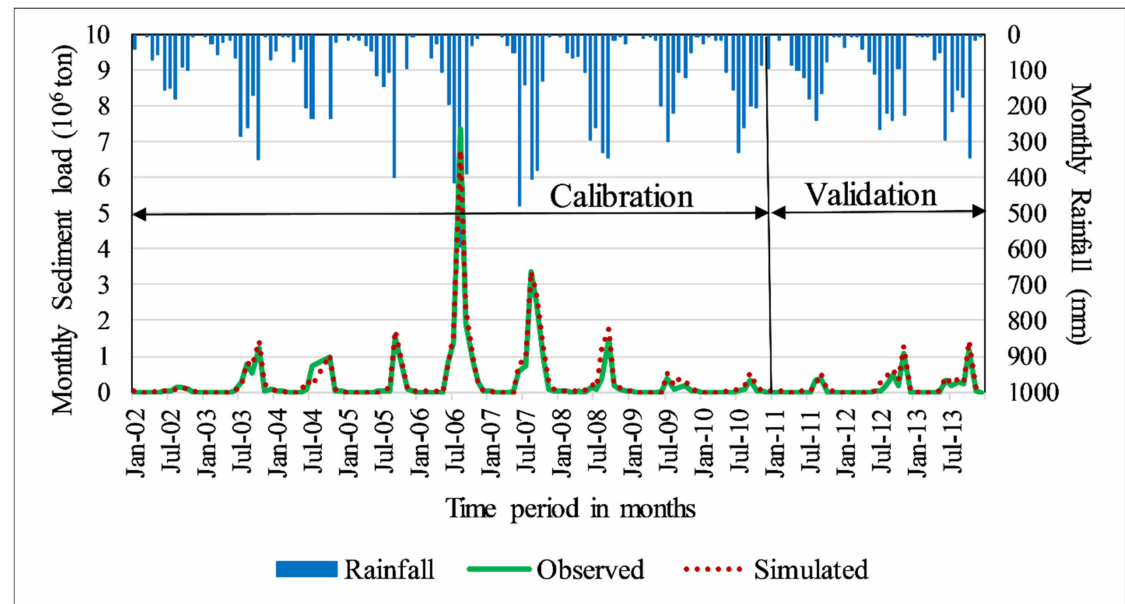
Figure 6. Observed versus simulated monthly sediment load during the calibration and validation period over the Nagavali river basin.